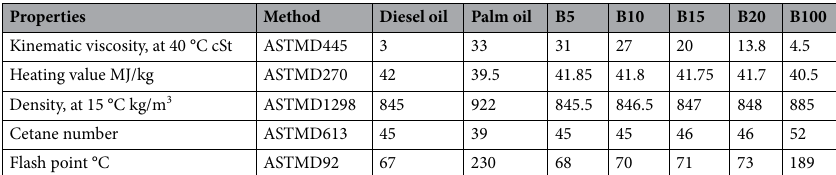
Table 1. Properties of diesel fuel, palm oil methyl ester and palm biodiesel